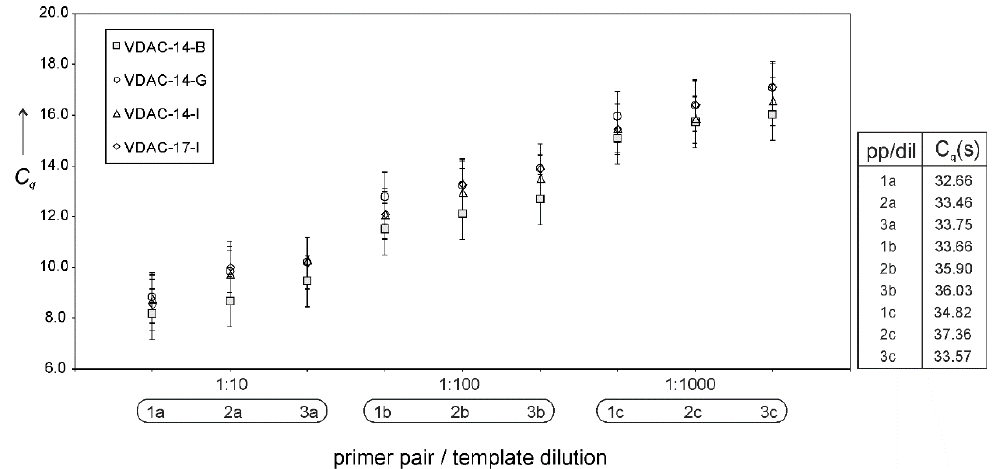
Figure 3. mRNA transcription levels (quantitation cycles, Cq) of different plasmids. Real-time amplification of three different dilutions of the as-obtained reverse-transcribed cDNA (a: 1:10; b: 1:100; c: 1:1000) with three different primer pairs (1, 2, and 3). Right: Cq values for the negative (no plasmid) control.